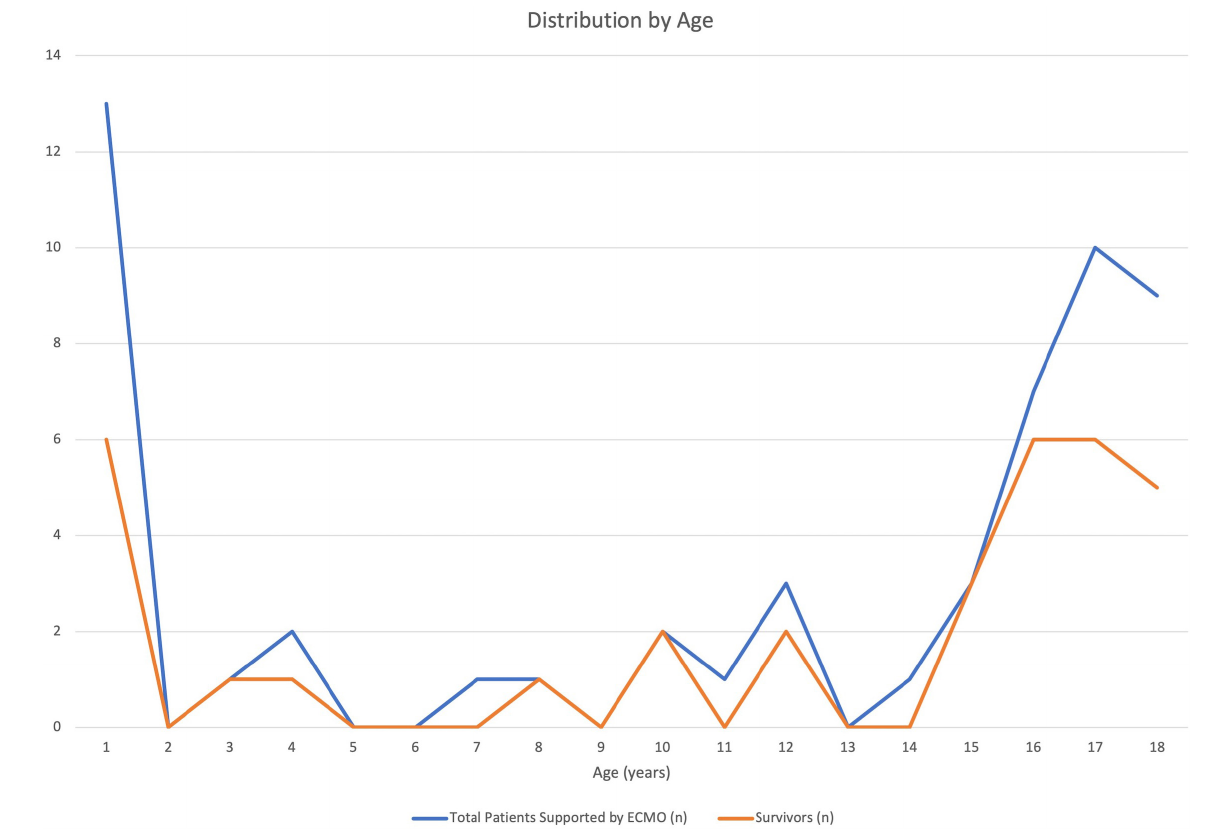
Frontiers in Pediatrics |